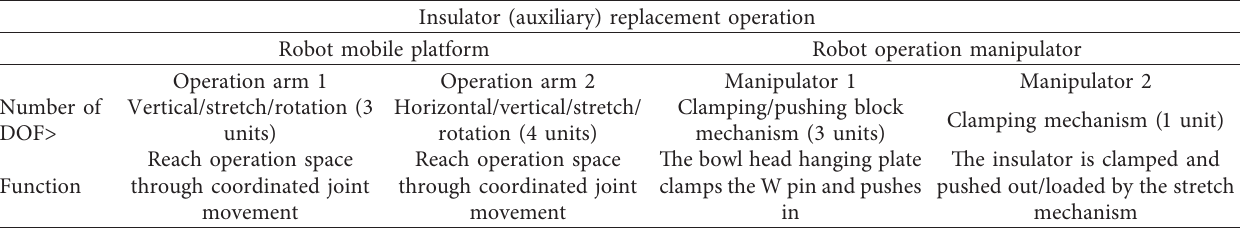
Table 1: Configuration analysis of insulator (auxiliary) replacement robot.